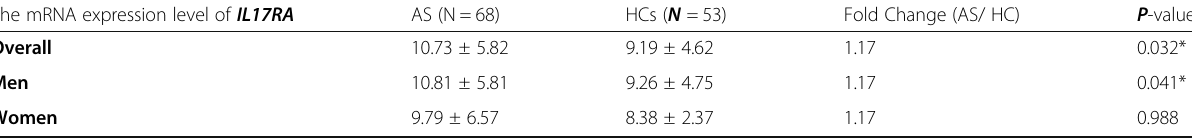
Table 3 IL17RA mRNA expression in AS and healthy control groups adjusted by sex (Median ± Standard Deviation) The mRNA expression level of